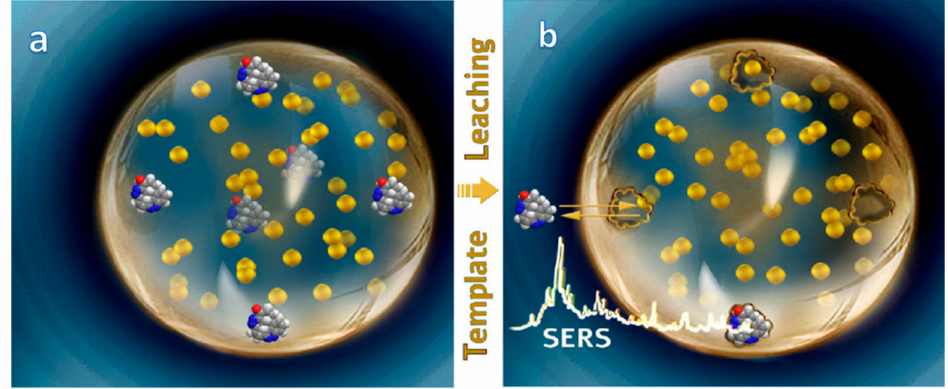
Figure 9. Schematic of the one-pot controlled synthesis of AuNPs@MIPs for improved SERS sensing ( a ) [89]. After the template removal, target molecules can selectively rebind with the cavities, and the analytes can closely contact with the Au NPs in the imprinted layer ( b ), which significantly improves the selectivity and